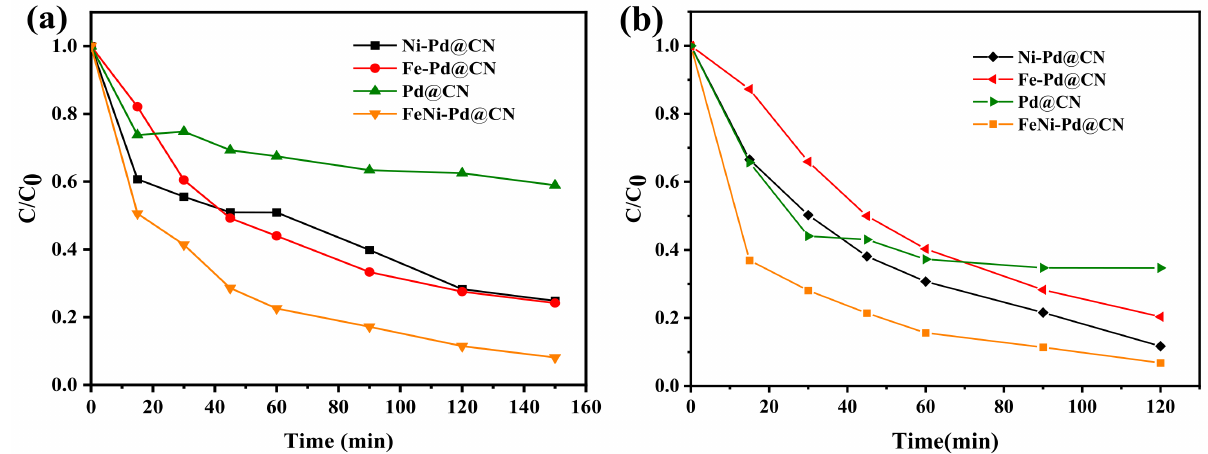
Figure 4. ( a ) Degradation of AR 73 (200 mg/L) and ( b ) TC (10 mg/L) by different catalysts (catalyst dosage: 2 g/L; FA: 46.6 mmol/L; air; 200 mL/min).